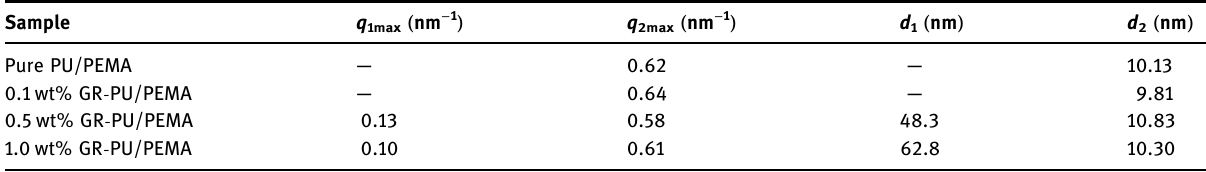
Table 1: Characteristic SAXS data of GR - PU/PEMA IPN composites Sample Pure